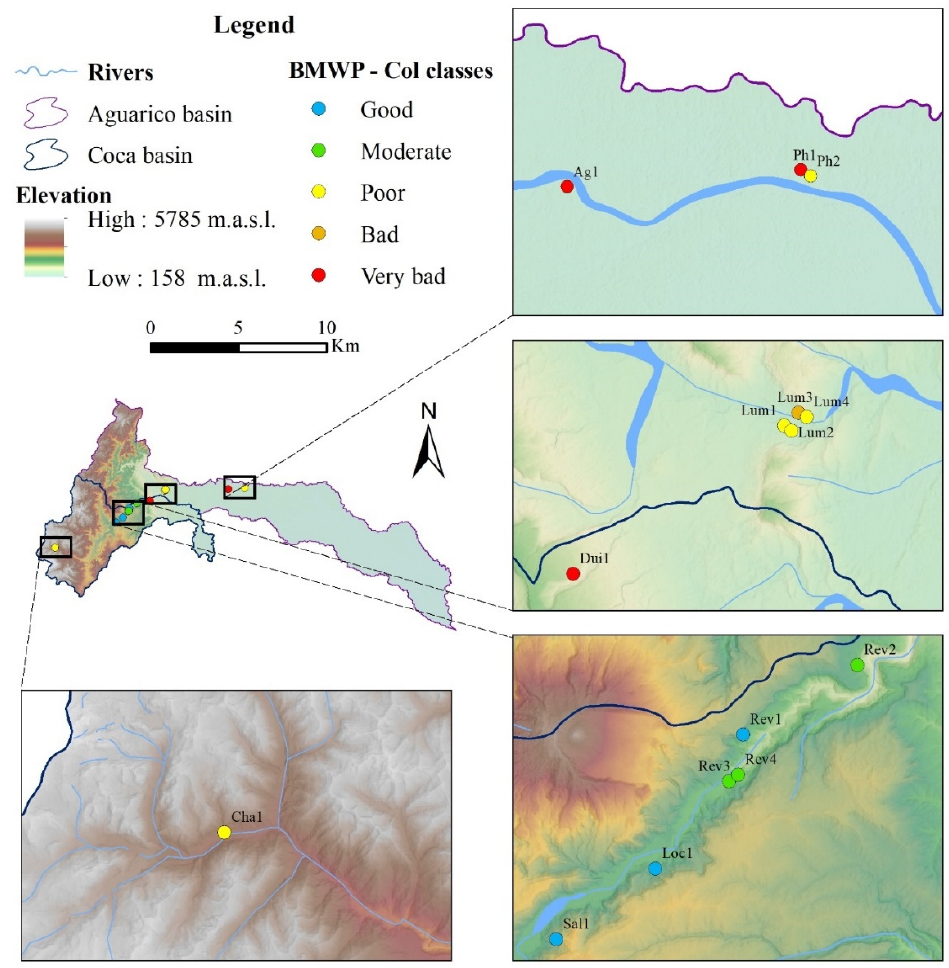
Figure 2. Map depicting the water quality of the sampled sites. Only the main rivers within the Coca River basin (CRB) and Aguarico River basin (ARB) are represented. Both the Coca River and Aguarico River are tributaries to the Napo River, which is one of the tributaries to the Amazon River.